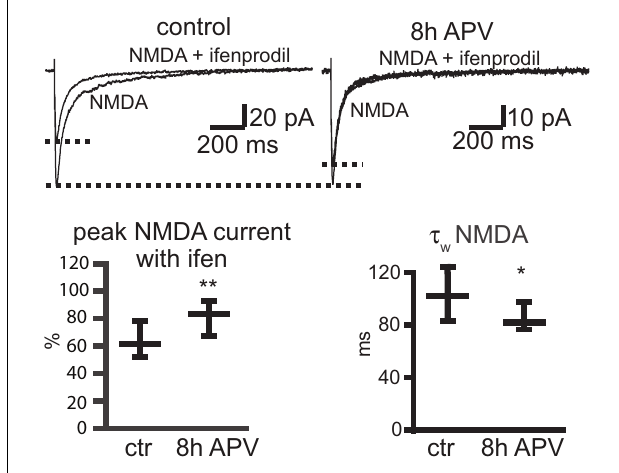
FIGURE 8 | APV treatment leads to a decrease in ifenprodil sensitivity and deactivation kinetics of synaptic NMDAR-mediated EPSCs. Synaptic EPSCs in CA1 pyramidal cells were evoked in hippocampal slices by stimulations of Schaffer collateral/commissural fi bers. Slices were incubated for 8 h in ACSF without (control) or with APV (8 h APV). NMDAR-mediated EPSCs were recorded at a holding potential of − 70 mV in Mg 2 + -free ACSF. The ifenprodil (10 µM) sensitivity was signifi cantly smaller in slices incubated for 8 h in APV than in control (ctr) slices (median ± IQR). There was also a signifi cant reduction in the τ of NMDAR-mediated EPSCs in cells of w APV-treated slices, consistent with an increase in the synaptic contribution of NR2A-type containing NMDARs (median ±